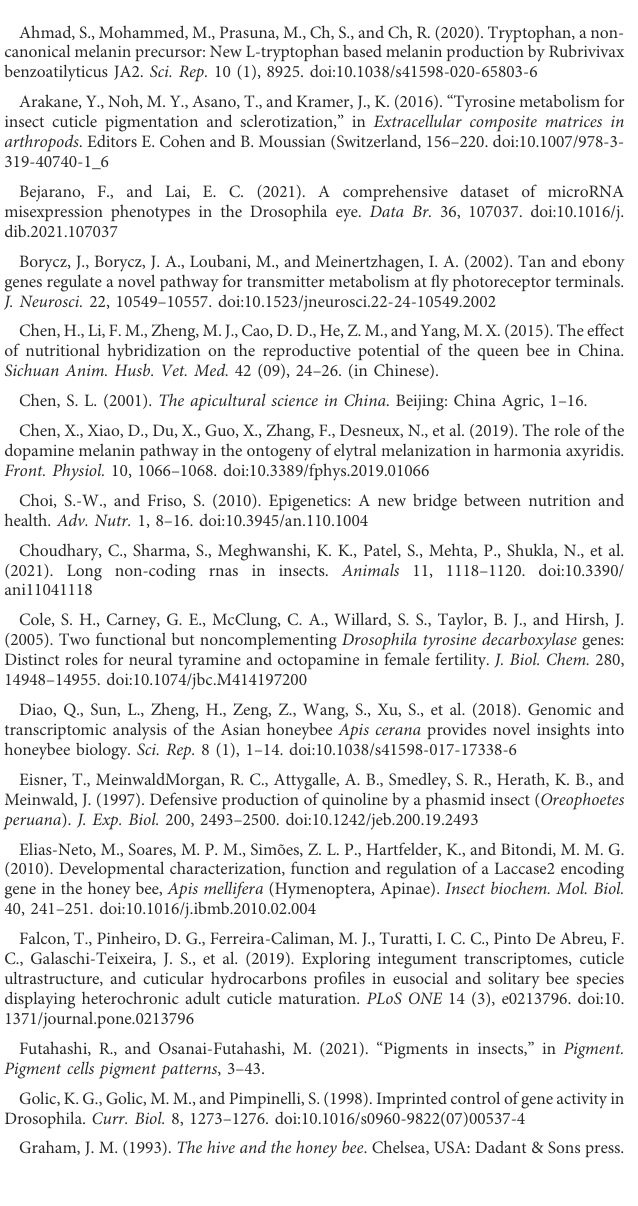
SUPPLEMENTARY TABLE S5 The lists of DEGs, DElncRNAs and DEmiRNAs and key KEGG pathways involved in body